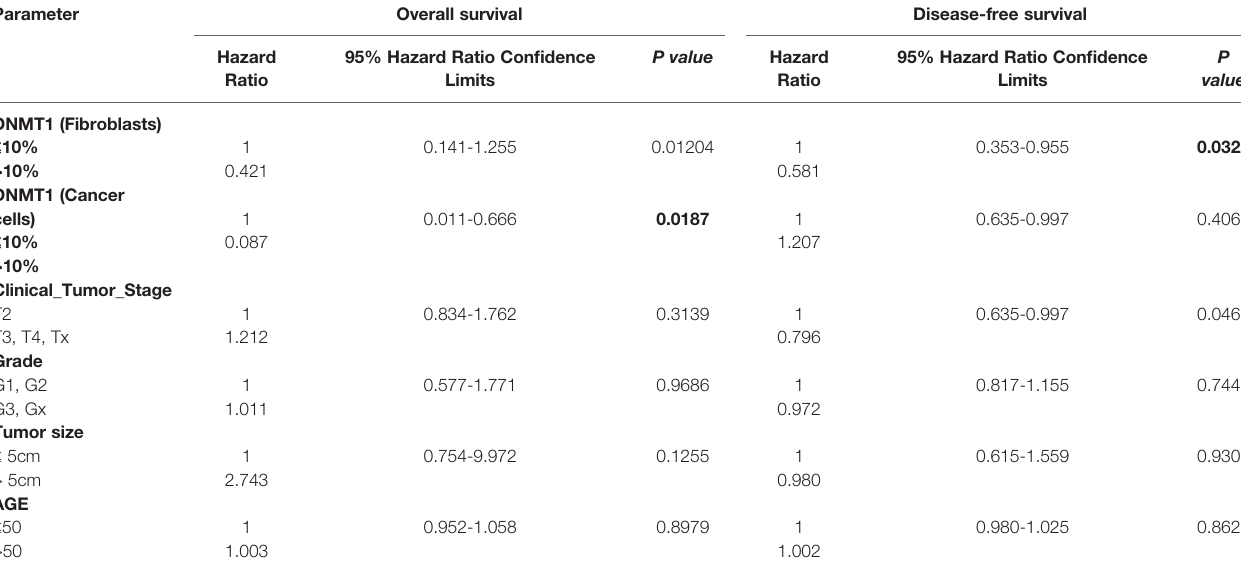
TABLE 3 | Univariate Cox proportional regression analysis on 5-year overall and disease-free survival of 100 LABC patients. Parameter